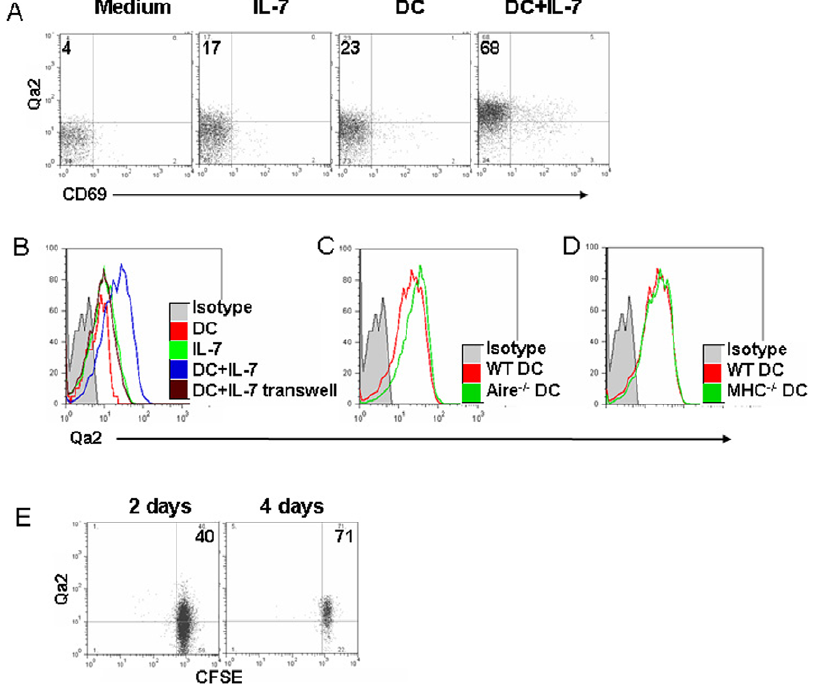
Figure 7. Dendritic cells promote the Qa2 upregulation of SP3 pre-RTEs. Purified SP3 thymocytes were cultured with IL-7 and FLDCs derived from C57BL/6 mice (A, B, E), and Aire -/- mice (C), and MHC class II -/- mice (D) for 4 days. The expression of Qa2 (B–D) and in some cases, Qa2 and CD69 (A) of live T cells were analyzed. (E) SP3 thymocytes upregulate their Qa2 expression in lymphoreplete mice. CFSE-labeled SP3 thymocytes were adoptively transferred into C57BL/6 mice. Qa2 expression was analyzed in CFSE + T cells in the lymph nodes and spleen at 2 and 4 days post-transfer. The numbers show the percentage of Qa2 + cells. The experiments have been repeated for 3 times.